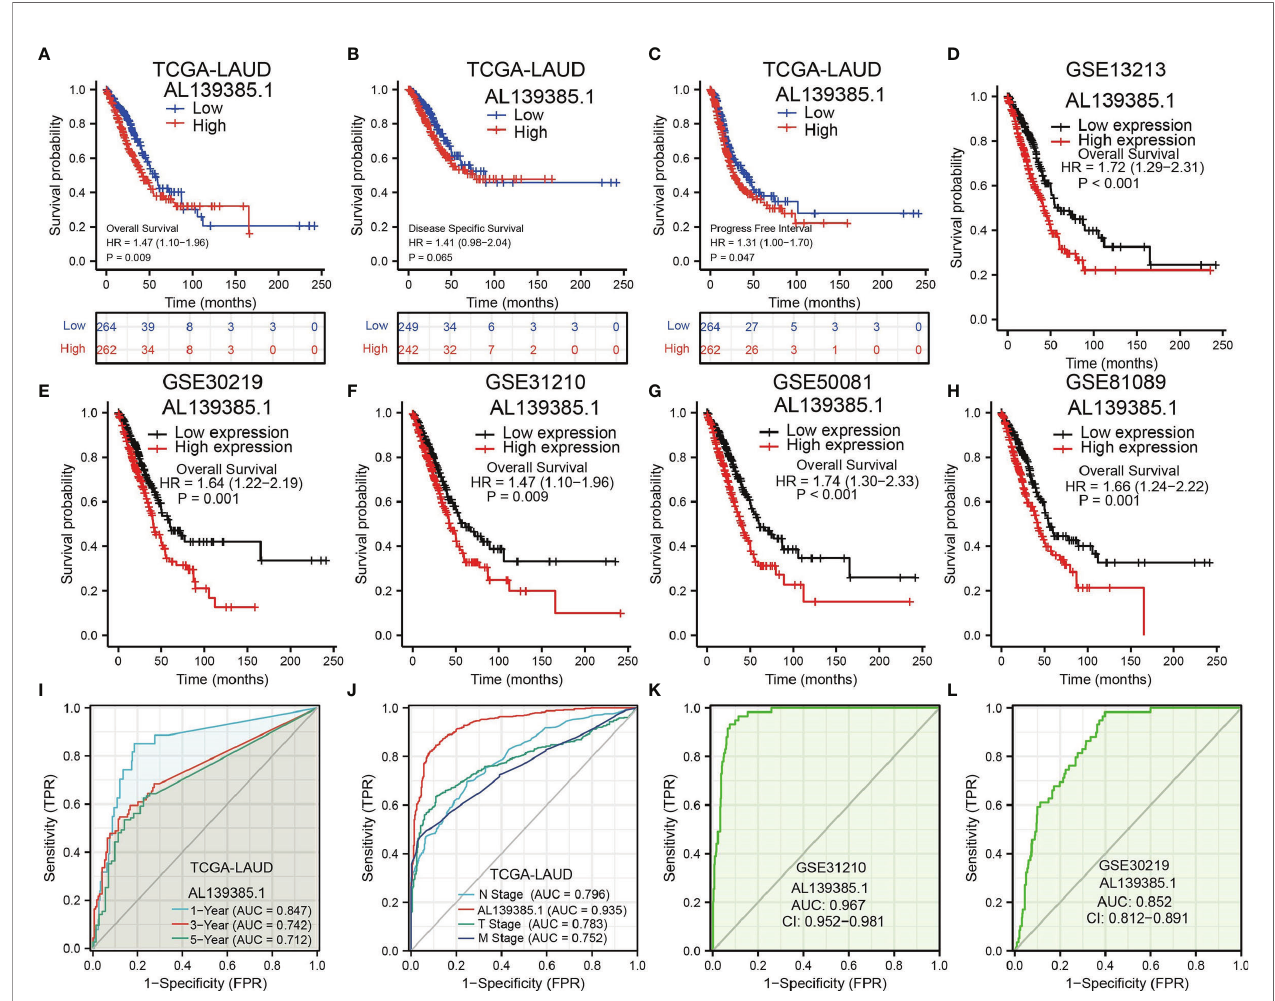
FIGURE 3 | The prognostic and diagnostic value of AL139385.1 expression in LUAD. (A-C) Kaplan – Meier survival curves showed that lung adenocarcinoma patients with high AL139385.1 expression exhibited poor overall survival, disease-speci fi c survival, and progression-free survival of AL139385.1 in LUAD determine by TCGA-LUAD dataset. (D – H) Survival curves of OS from GEO datasets. (I) ROC curves showed that the AUC of AL139385.1 for predicting 1-, 3-, and 5-year survival of patients is 0.847, 0.742, and 0.712, respectively. (J) The prediction performance of AL139385.1 is higher than TNM stage. (K, L) ROC curves were used to determine the diagnostic value of AL139385.1 in lung adenocarcinoma based on GEO